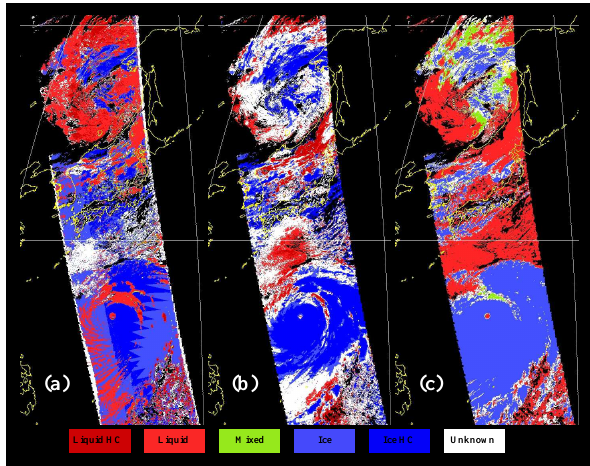
Fig. 3. Results of the partial cloud phase index retrieved from (a) POLDER polarization algorithm, (b) MODIS SWIR based algo- rithm and (c) MODIS bispectral IR algorithm.